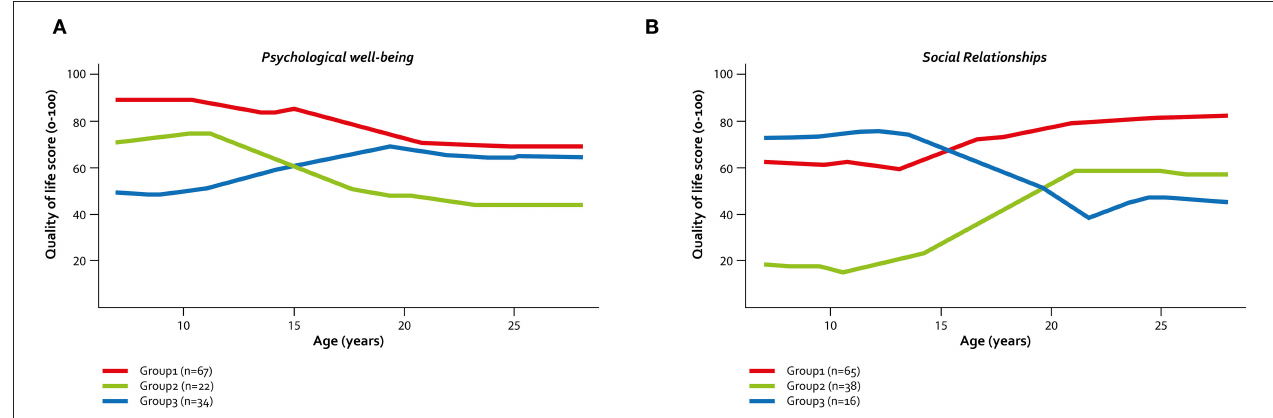
FIGURE 3 | Identified QoL trajectories in individuals with CP. (A) QoL trajectories in psychological well-being. (B) QoL trajectories in social relationships—SPARCLE cohort—France, Germany, Italy, Sweden.